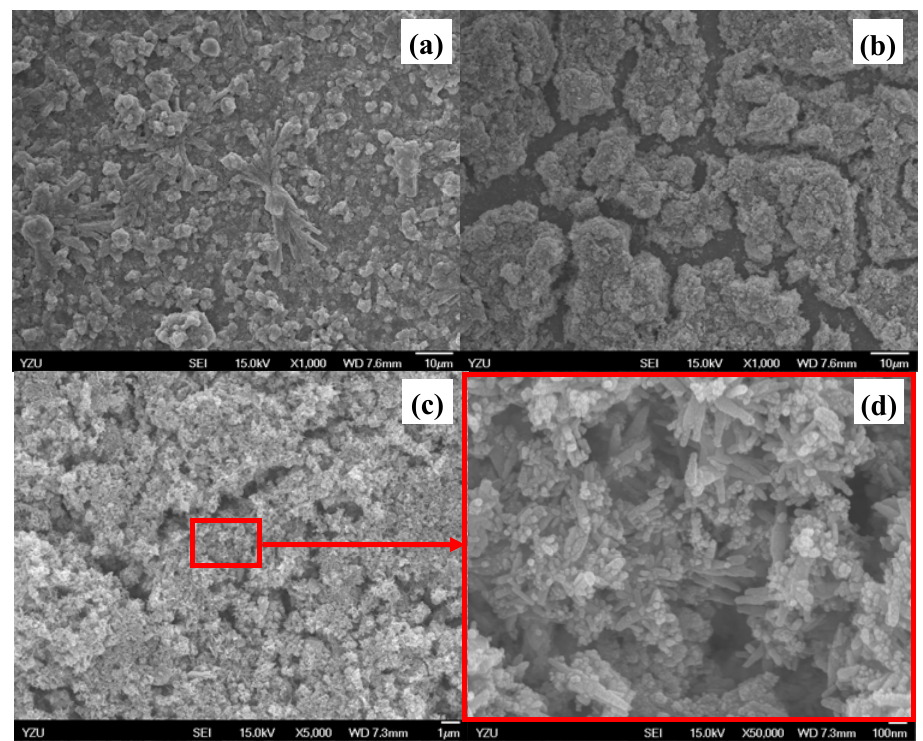
Figure 1. SEM microphotos of: (a) fresh as-synthesized CuO/ZnO-Al catalyst washcoated on Fe-Cr-Ni stainless steel 304 foil under the conditions of: (b) drying at 298 K for 5 h, (c) and (d) calcination at 623 K for 2 h, respectively.